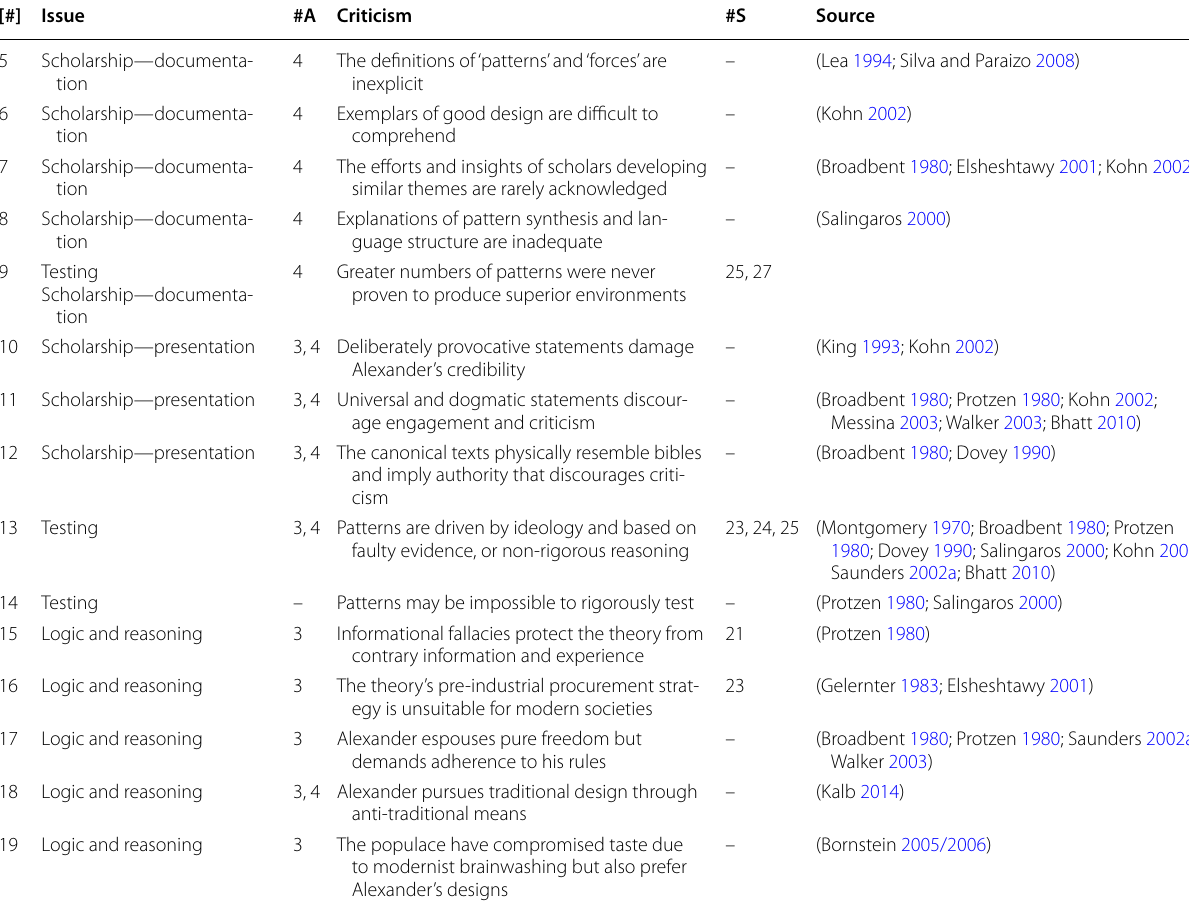
Table 2 Criticisms of Alexander’s second theory of architecture: development and